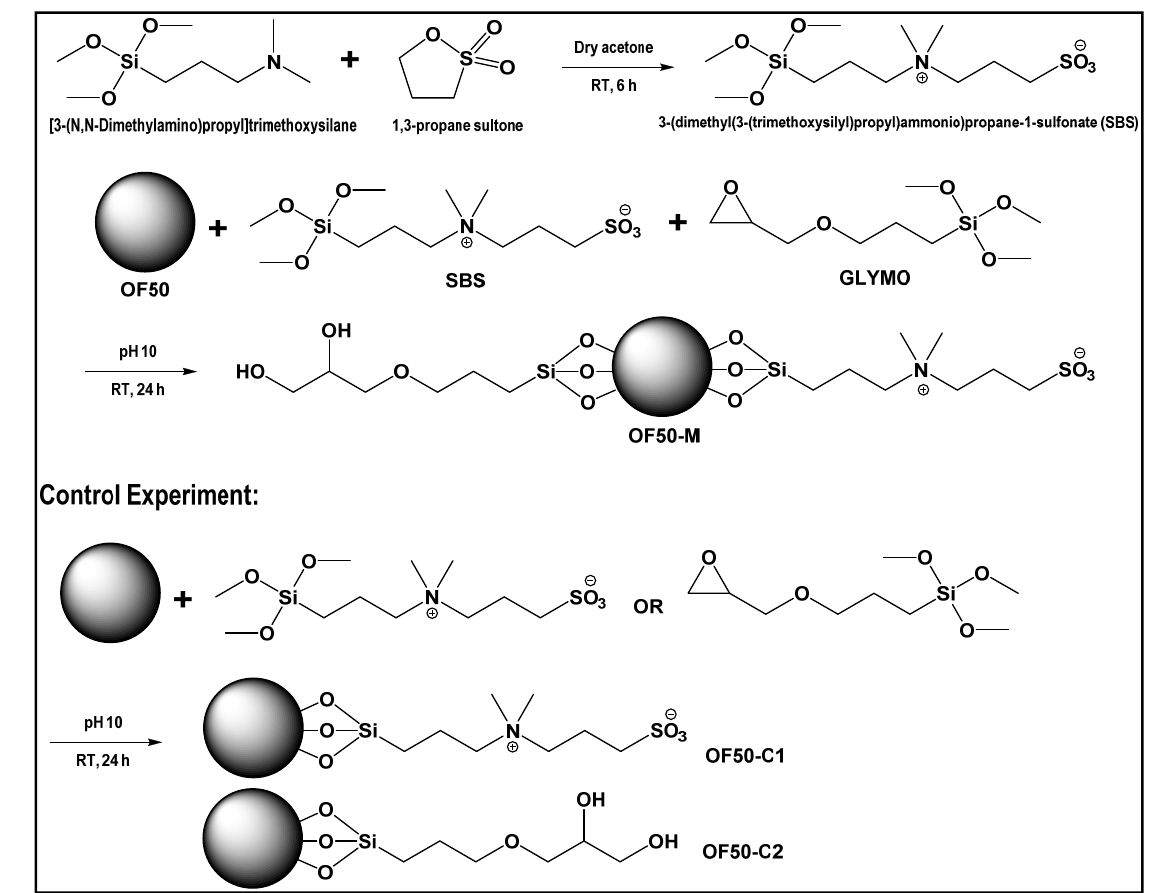
Figure 1. Synthesis of 3-(dimethyl(3-(trimethoxysilyl)propyl)-ammonio)propane-1-sulfonate (SBS) and surface modification of Levasil OF50 using SBS and (3-glycidyloxypropyl) trimethoxysilane (GLYMO).